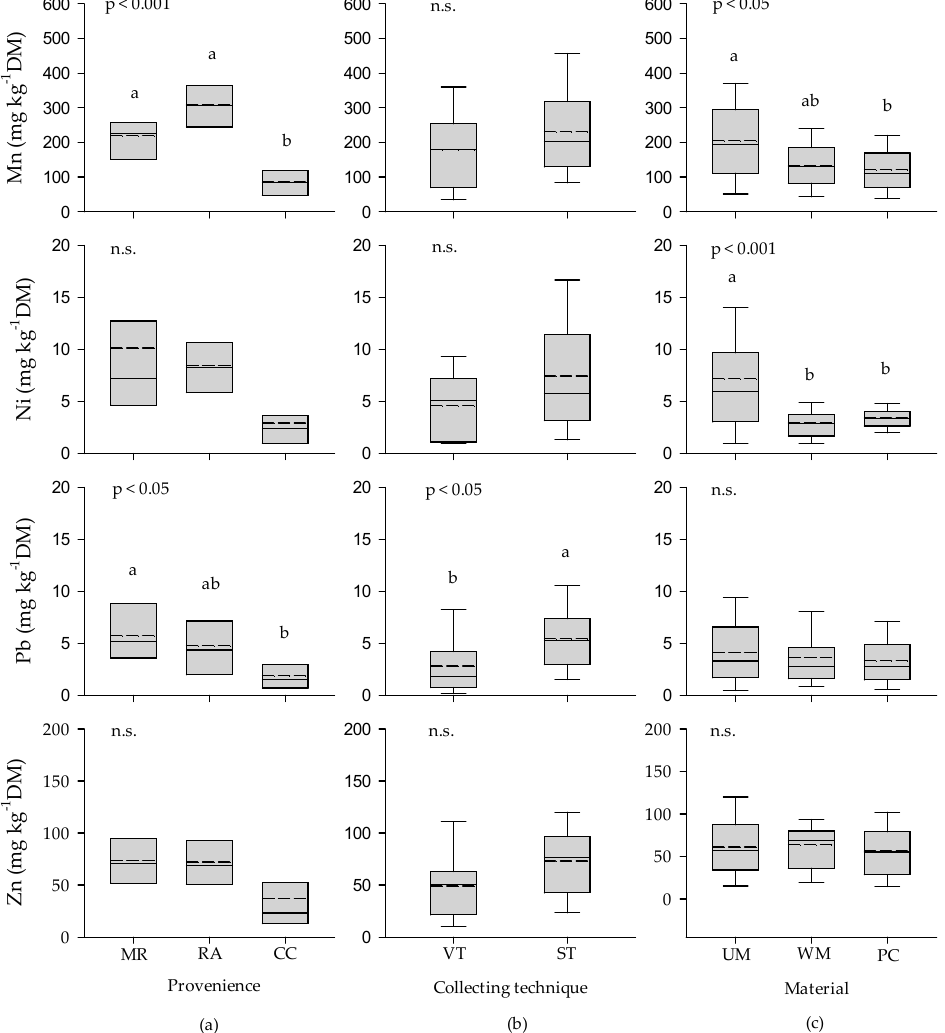
Figure 2. Concentration of heavy metals Mn, Ni, Pb and Zn in leaf litter of urban street trees from ( a ) various provenience (main road—MR, residential area—RA, city center—CC) collected by ( b ) different technique (vacuum—VT and sweeping technique—ST) and ( c ) with various degrees of material processing (unwashed material—UM, washed material—WM, press cake—PC). Whiskers indicate the 5th and 95th percentiles. Dashed lines indicate median values. Different letters indicate significant differences; n.s., not significant. Samples with values below the analytical detection limit were included into the dataset, using the detection limit as a conservative estimate of the concentration.